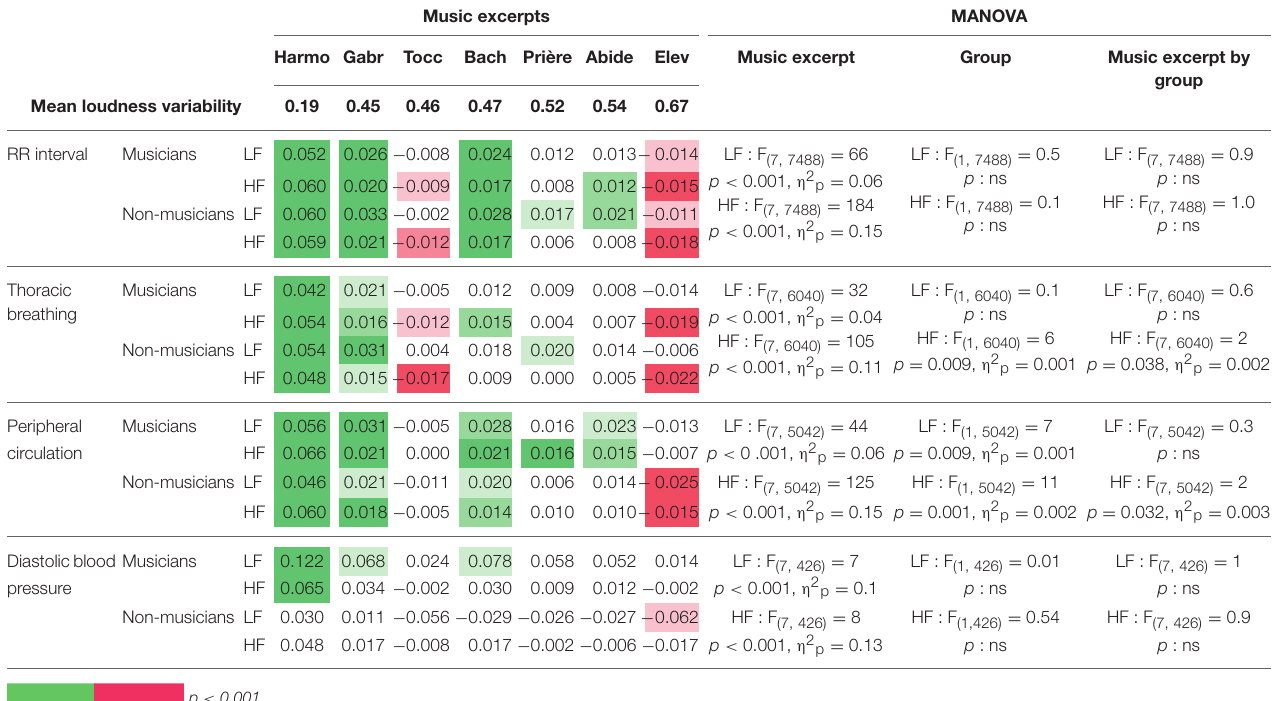
TABLE 2 | Effect of different music excerpts on group synchronization of physiological